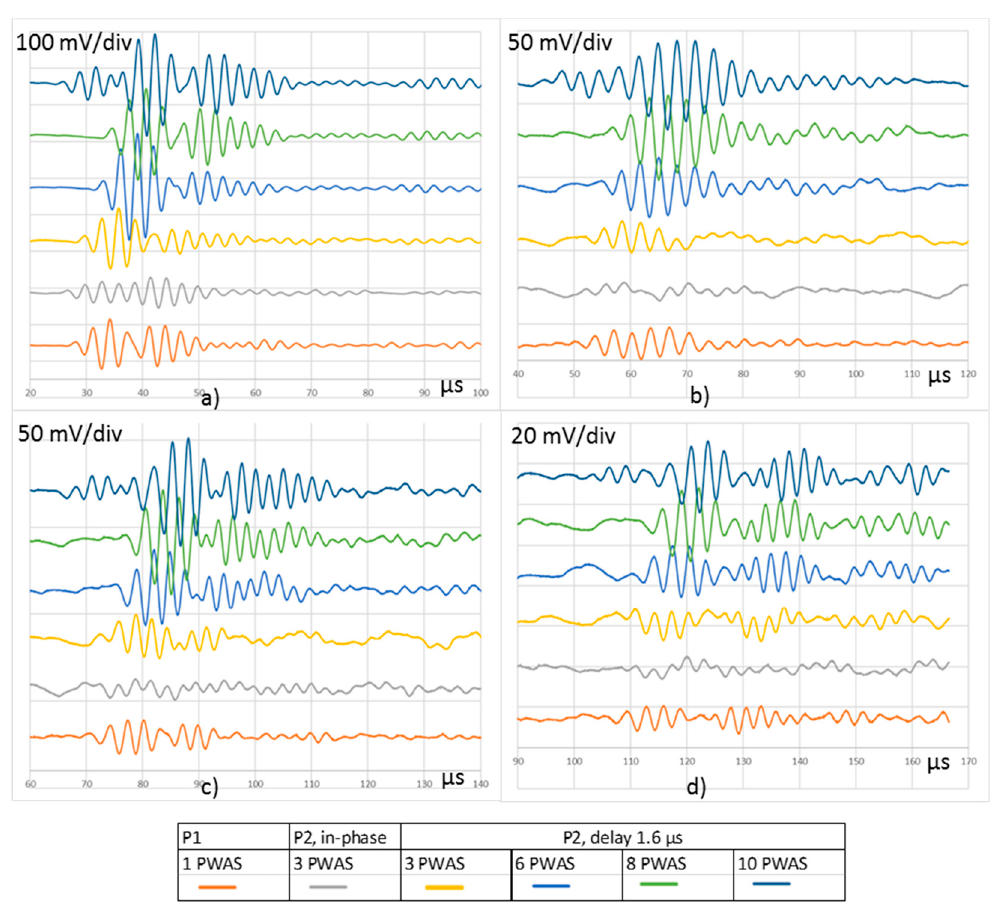
Figure 12. Signals acquired in ( a ) R5, ( b ) R6, ( c ) R7, and ( d ) R8 following different procedures. An offset was added to each signal for easy display.